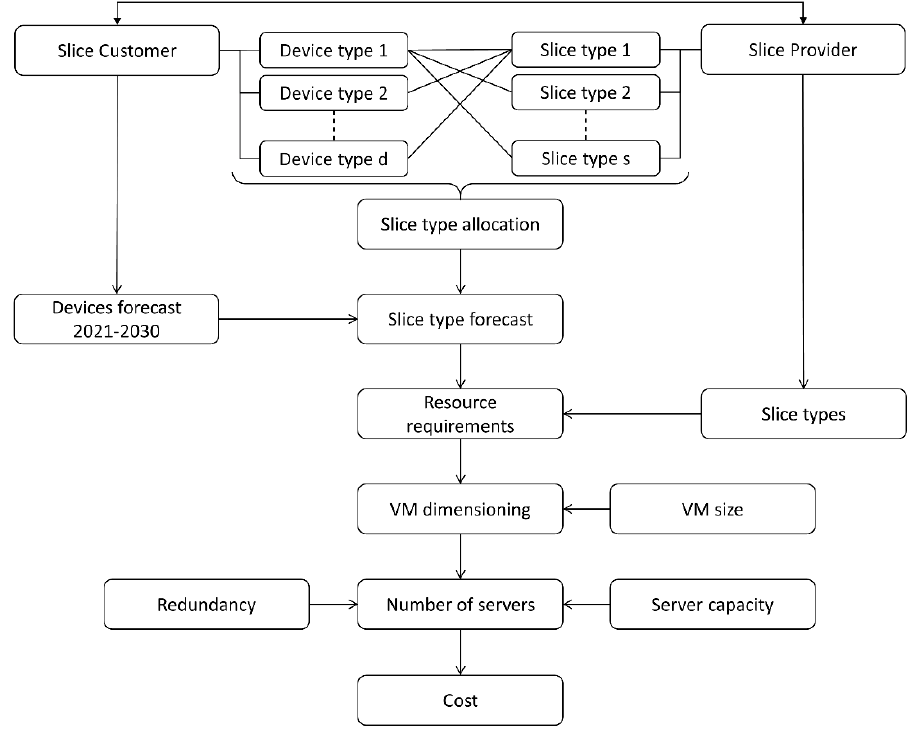
Figure 3. Cost Model for Virtualization Infrastructure.